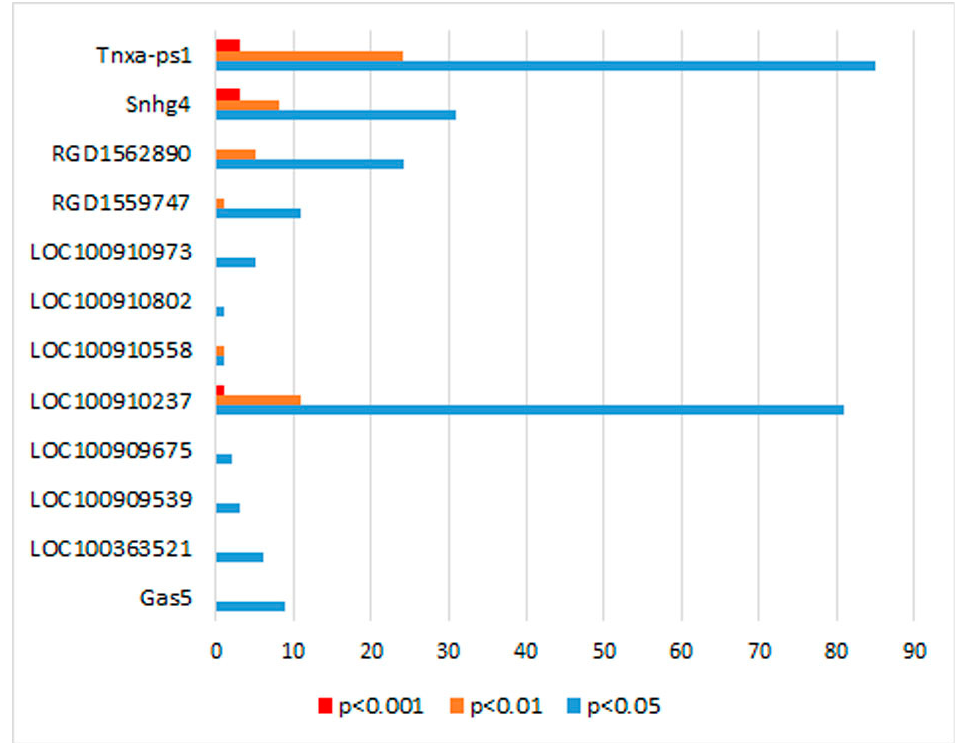
Figure 1. The number of DEGs whose expression correlates with the expression of lncRNAs in the hypothalamus of hypertensive ISIAH and normotensive WAG rats. Correlations with the level of transcription of genes differentially expressed in the hypothalamus of ISIAH and WAG rats were found only for 12 out of the 22 expressed lncRNAs listed in Table 1. The color indicates the significance of the correlation. The levels of significance are based on the two-tailed test (Pearson’s correlation analysis). The x -axis shows the number of DEGs.